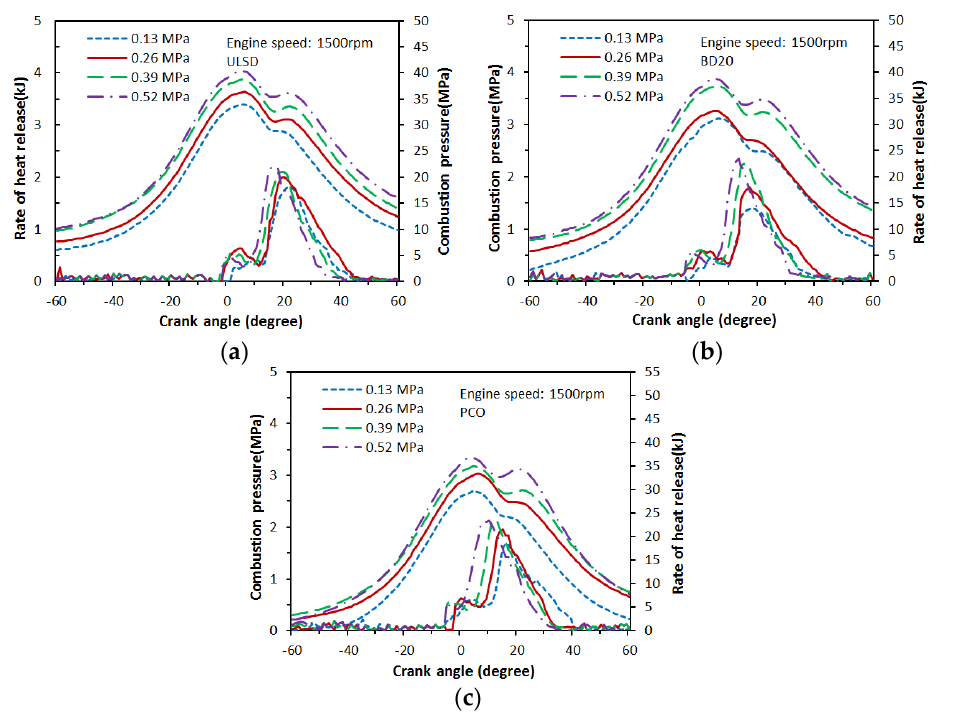
Figure 4. Effect of BMEP on combustion pressure and ROHR according to test fuels. ( a ) ULSD (ultra low sulfur diesel); ( b ) BD20 (20% canola oil blended with 80% ULSD by volume); ( c ) PCO (pure canola